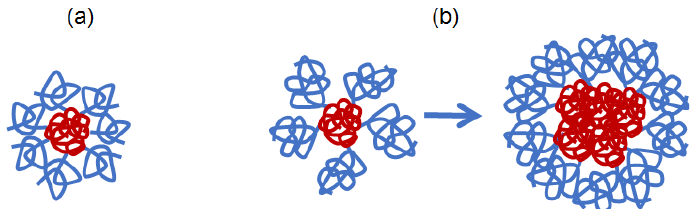
Figure 11. Model conformations for APE O -g-PiPrOx samples 1 ( a ) and 2 and 3 ( b ) in water. Table 3. Comparison of PiPrOx bottle brushes with different rigidity of the APE main chains. Copolymer